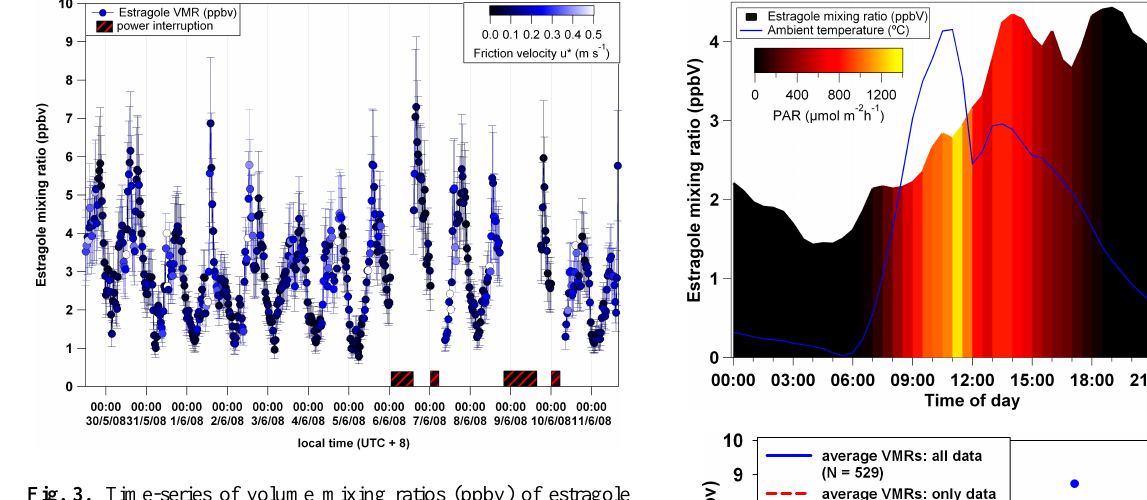
Fig. 3. Time-series of volume mixing ratios (ppbv) of estragole measured by PTR-MS above the oil palm canopy (local time [UTC+8]). The dots are coloured by friction velocity ( u ∗ ) to show that potentially large fluxes likely occurring later in the day could be missed out in eddy covariance because of low values of u ∗ (corre- sponding to black – dark blue). Error bars denote an estimated 30% error in obtaining VMRs using an empirical sensitivity derived from relative transmission (see Sect. 2.2).